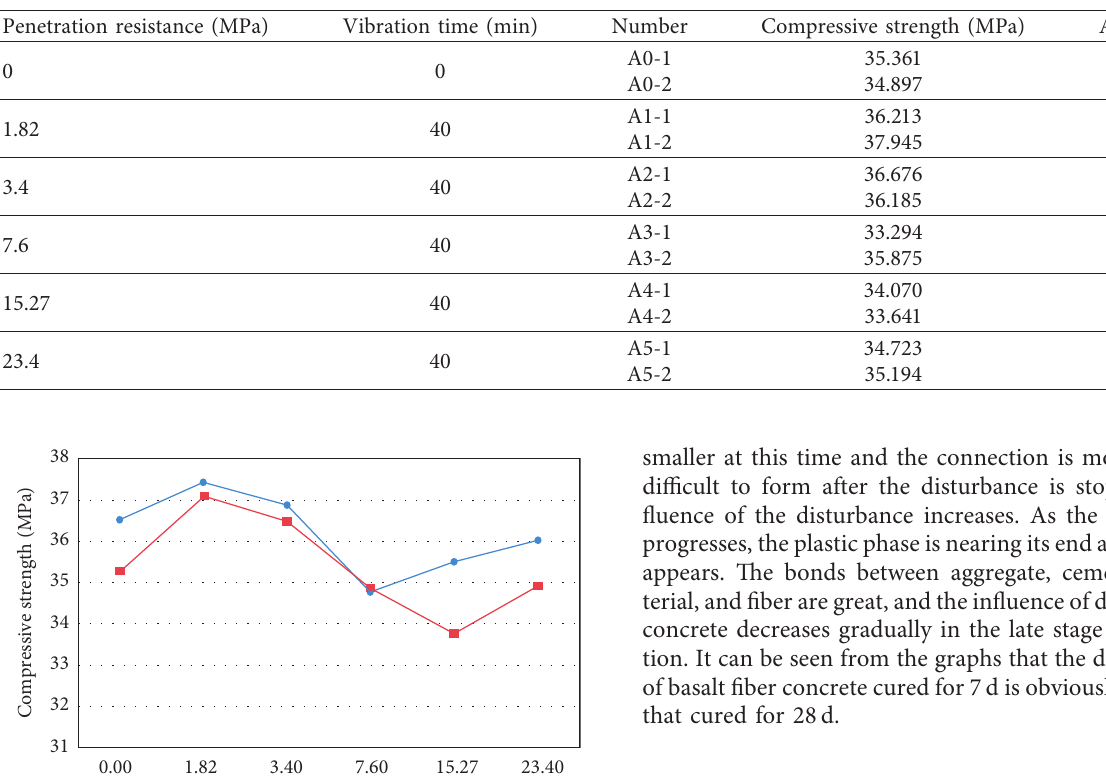
Table 7: Compressive data of plain concrete.